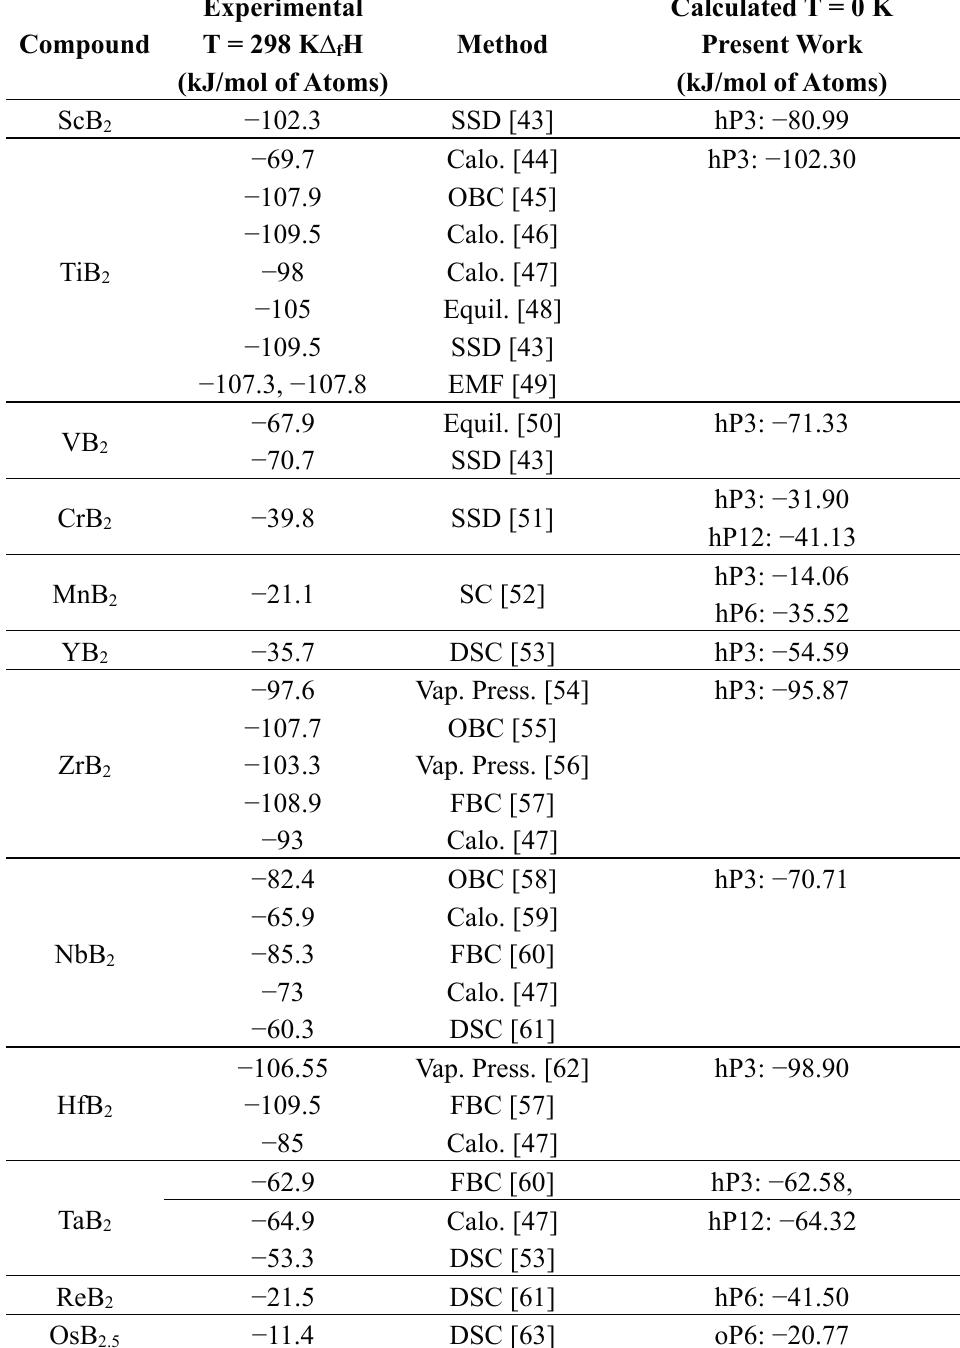
Table 3. Experimental and calculated values of the formation enthalpies of TMB 2 compounds.